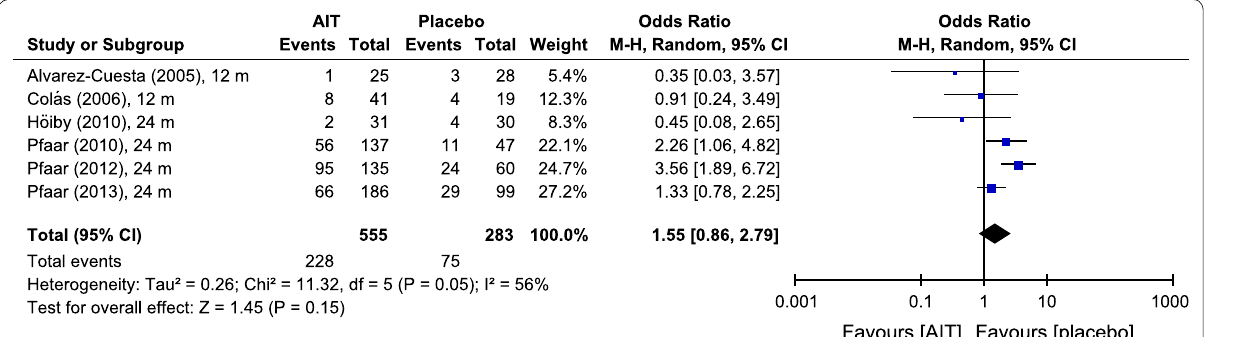
Fig. 7 Odds ratios for local reactions under AIT with DPAEs and placebo. Data extracted from the original studies. Outcome: number of patients developing local reactions after immunotherapy administration. AIT allergen‑specific immunotherapy, CI confidence interval, m